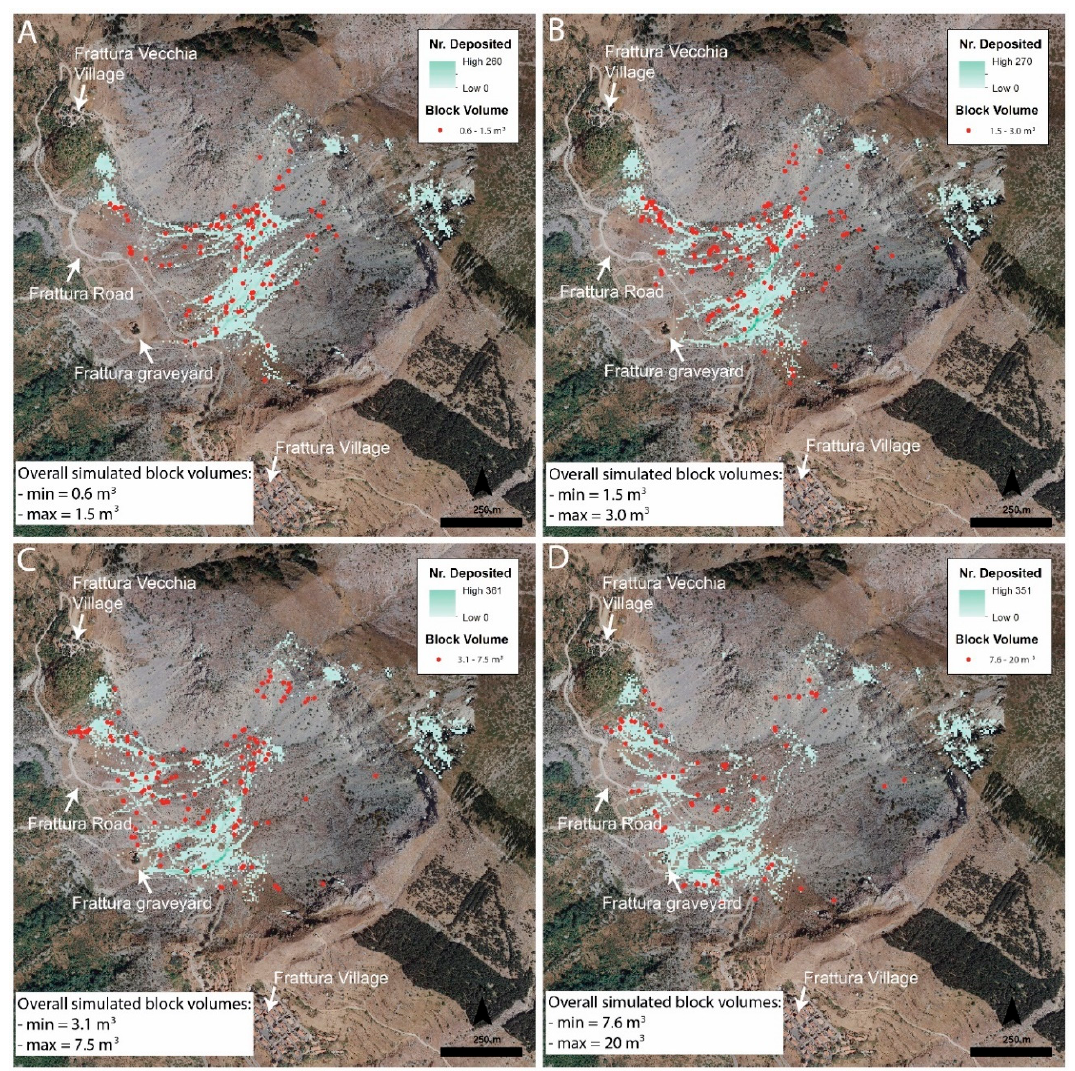
Figure 14. Results of rockfall simulations showing the number of deposited blocks (“Nr. Deposited” in the legend) when using ranges of block volumes from DFN 2: 0.6–1.5 m 3 ( A ), 1.6–3 m 3 ( B ), 3.1–7.5 m 3 ( C ) and 20 m 3 ( D ). Red dots represent recent rockfall events with the same volume of simulated rockfalls.